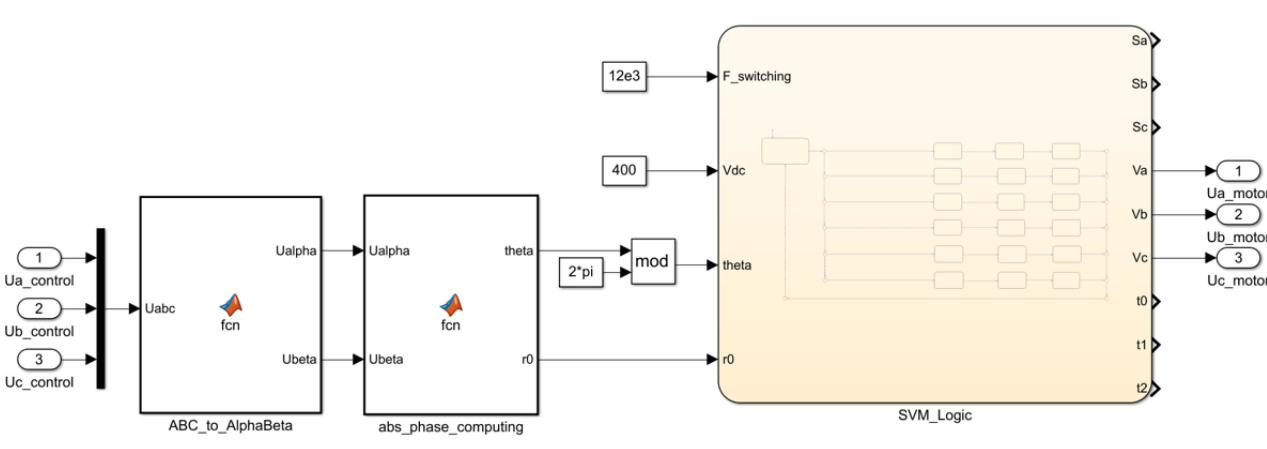
Figure 14. Simulink environment implementation of the SVM modulation